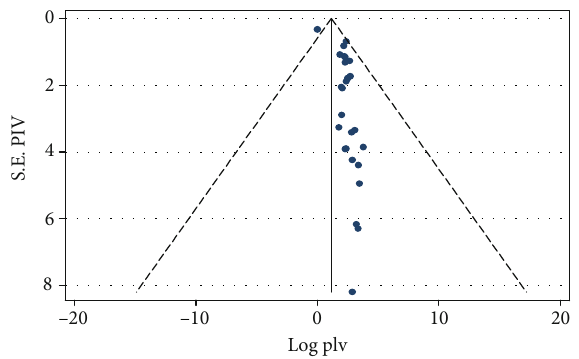
Figure 7: Funnel plot to test the publication bias of depression in 26 studies with 95% con fi dence